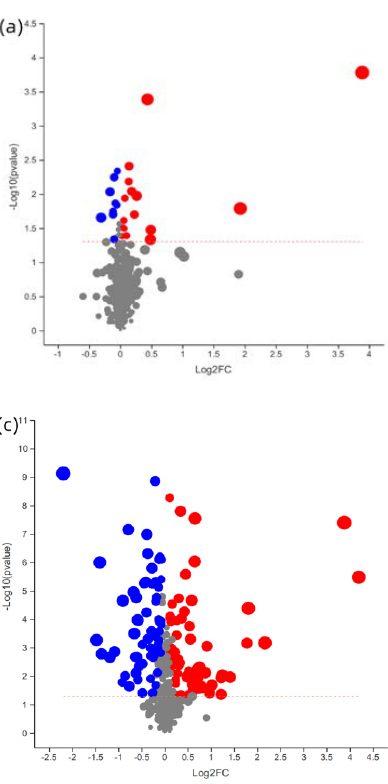
Figure 5. Volcano plots for the potential metabolomic features of muscle samples. ( a ) Volcano plots between CAP-30 and control group; ( b ) CAP-70 and control group; and ( c ) CAP-100 and control group.